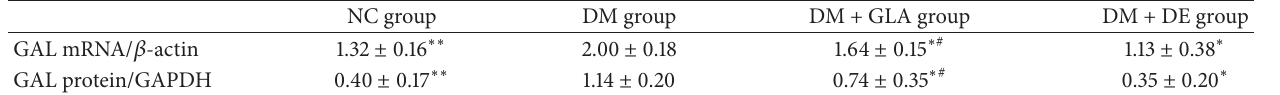
Table 5: The relative amount of GAL mRNA and protein ( 𝑥 ± 𝑠 ).